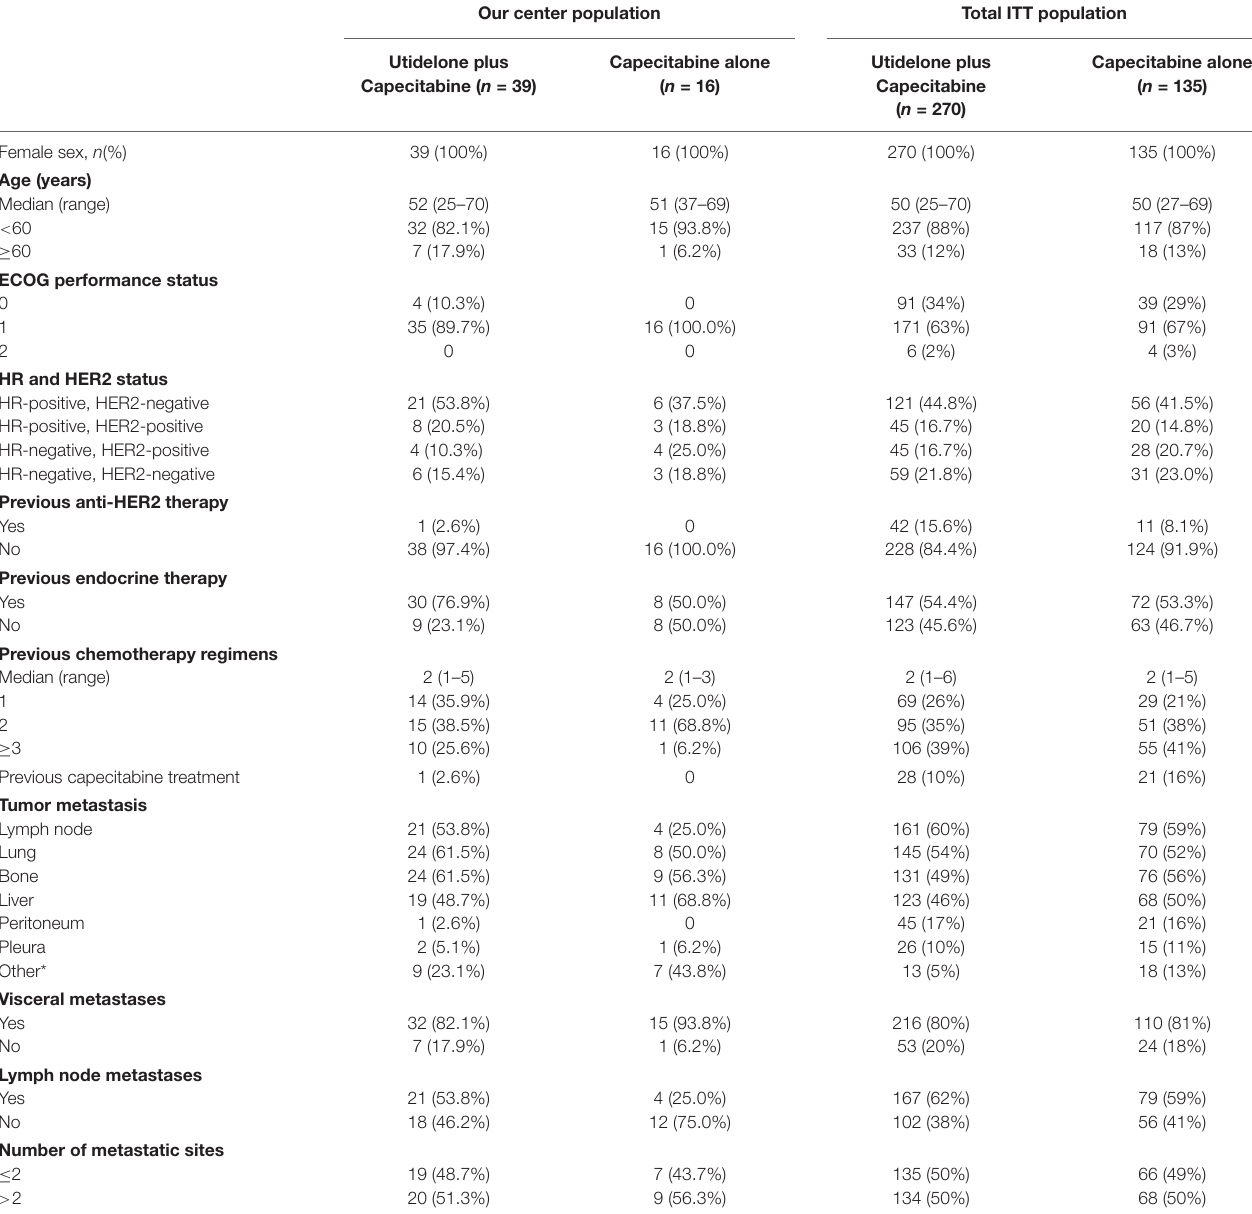
TABLE 1 | Baseline patient demographics and characteristics for our center population and the total intention-to-treat population.